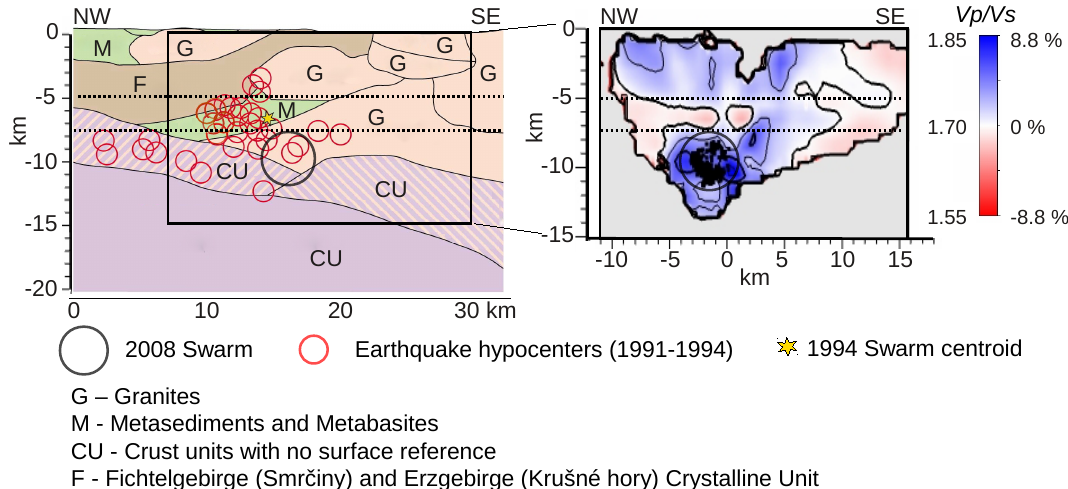
Figure 7. Comparison between a geological interpretation of the Nový Kostel Seismic Zone (left), based on the 9HR/91 seismic profile and gravity modelling (Nehybka and Skácelová, 1997; Tomek et al., 1997) and the Vp / Vs weighted average model (right). The Vp / Vs model profile is parallel to 9HR/91 and passes through the focal zone (profile C-C’ in Fig. 1). Only areas constrained by the data are shown. Dashed lines show the layer exhibiting low Vp / Vs values, black circle shows the location of the 2008 swarm, red circles show past earthquake hypocentres (1991–1994) and yellow star shows the 1994 swarm centroid. Crust Units: G – granites, M – metasediments and metabasites, CU – crustal units with no surface reference, F – Fichtelgebirge and Erzgebirge crystalline unit. Geological profile (left) modified from Weise et al.